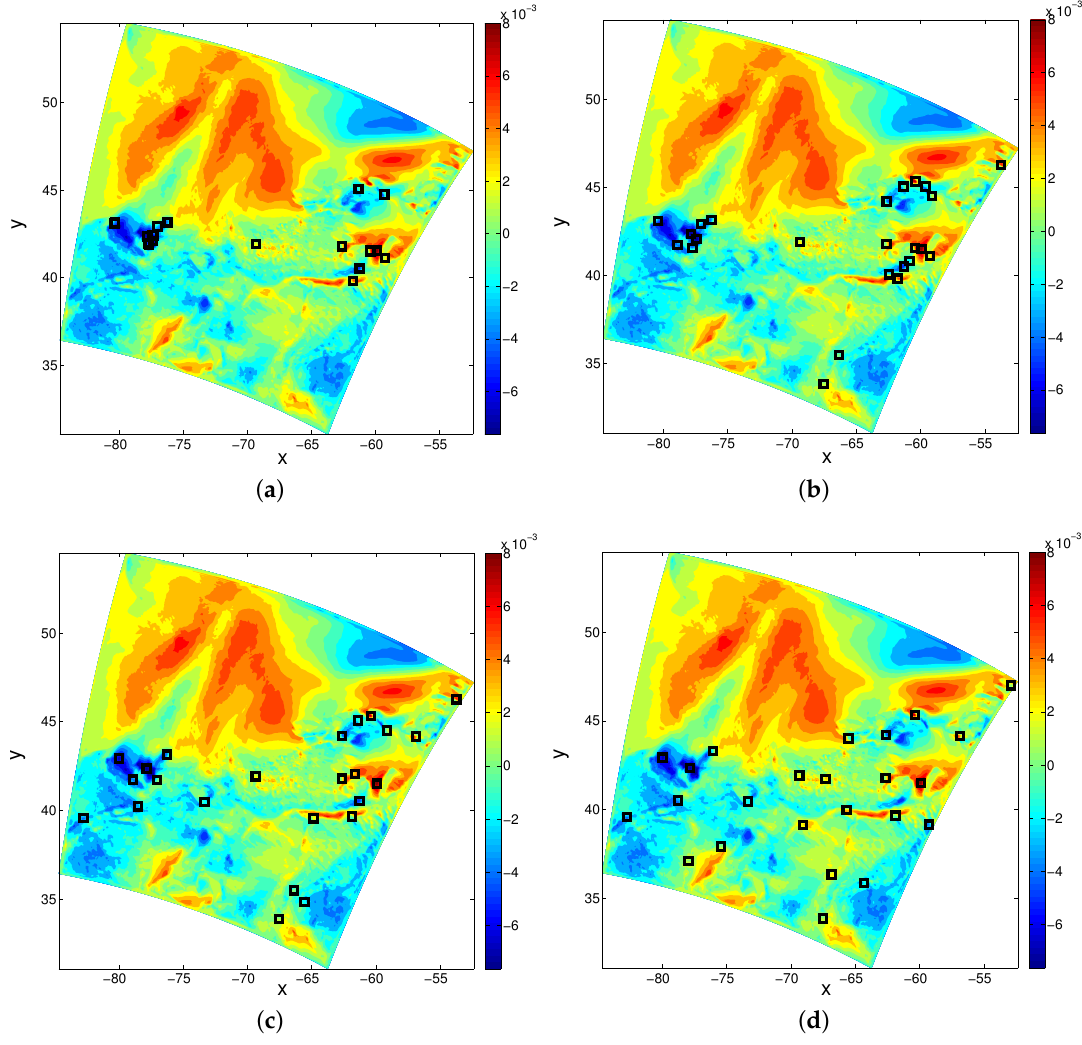
Figure 4. Location of 24 sensors placed on the extrema of the first six modes superimposed on the contour of the first mode with different size of the exclusion disk. ( a ) R = 0; ( b ) R = 0.5; ( c ) R = 1; ( d ) R = 2.